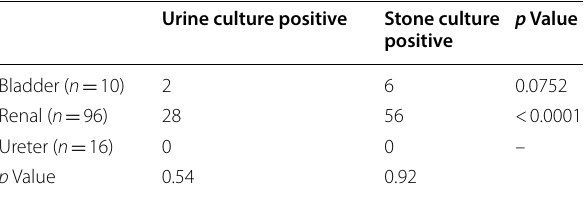
Table 4 Comparison of urine and stone culture based on stone location Urine culture positive